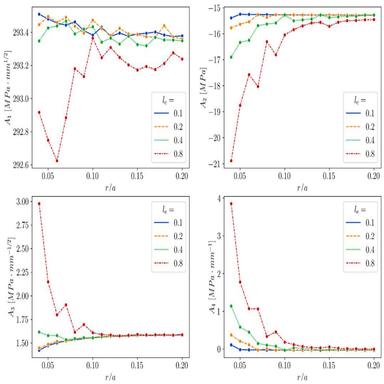
Convergence of 1 , … , 4 for various crack tip distances of integration paths, different mesh sizes e , and fixed number of integration points = 100.